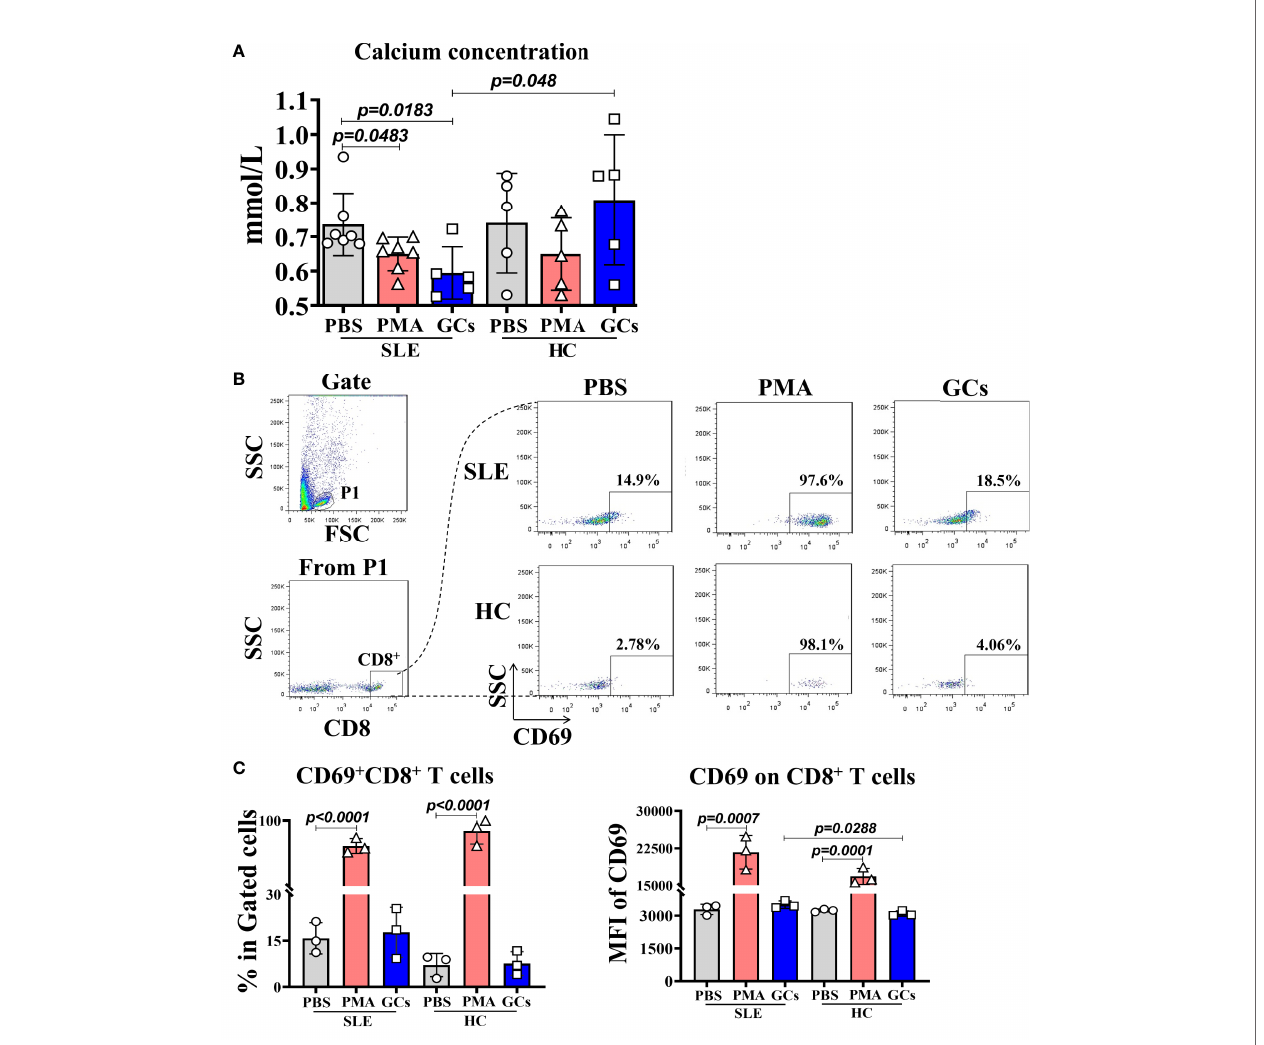
FIGURE 4 | The calcium concentration in the supernatant and the activated CD8 + T cells in PWBCs of SLE or health background cultured in vitro after PMA or GCs stimulation. The PWBCs of SLE or health background were stimulated with PMA or GCs in medium containing certain amount of calcium. The culture supernatants and PWBCs were harvested at 15 min and 4 h post-stimulation, respectively, and detected for calcium concentration in the supernatants and CD69 expression on CD8 + T cells in the PWBCs. (A) Calcium concentration in the culture supernatants. (B) Gating for CD8 + T cells from lymphocytes in the PWBCs. (C) Percentages of CD69 + CD8 + T cells and MFI of CD69 on CD8 + T cells in the